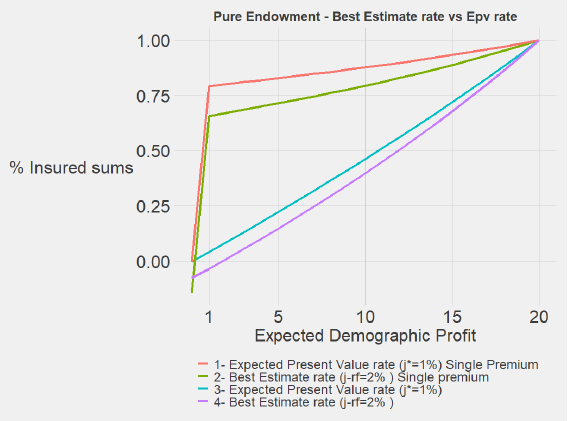
Figure 3. Expected present value and best estimate